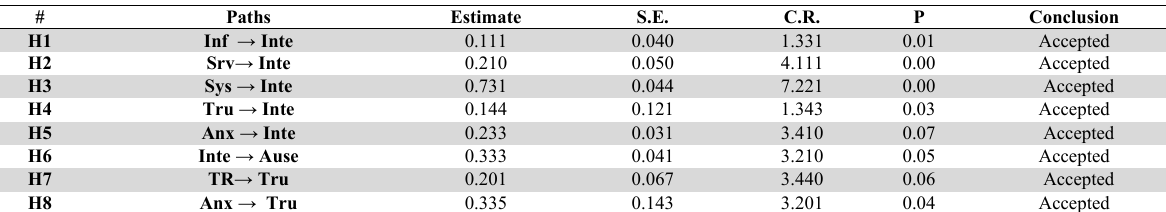
Results of Hypotheses Testing